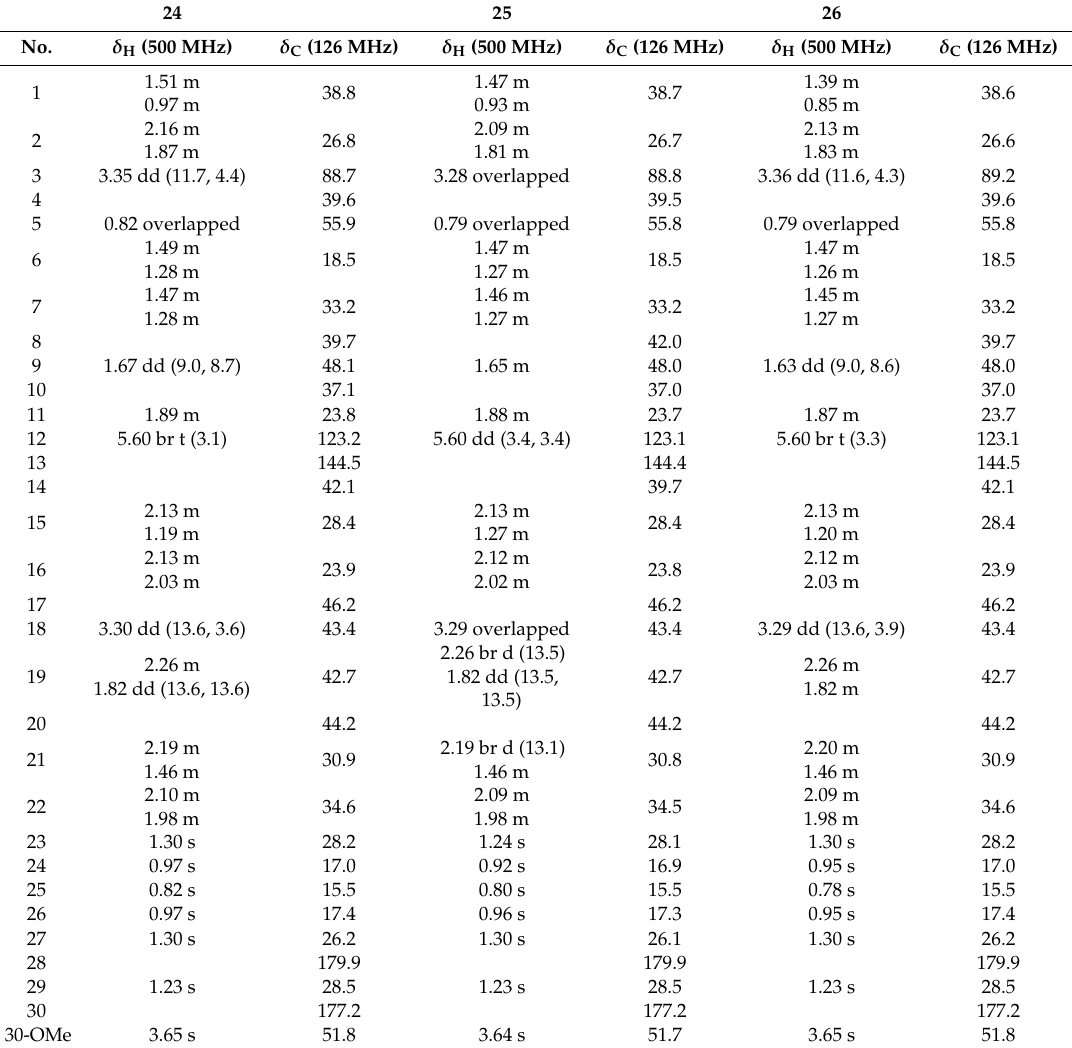
Table 9. 1 H- and 13 C-NMR data of 24 – 26 in Pyridine- d 5 ( δ in ppm, J in